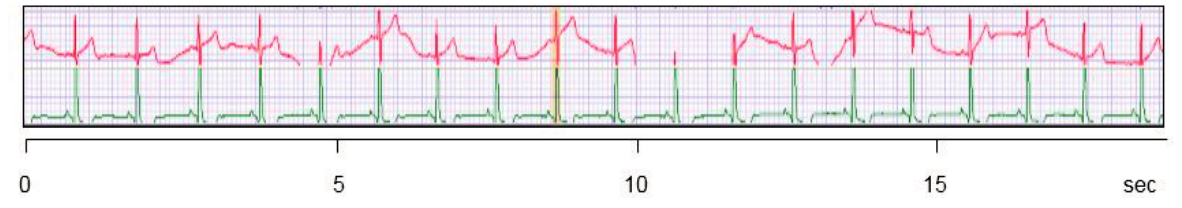
Figure 4. Electrode signals. Red : embroidered moist electrodes made from Ag-coated yarn worn with a chest belt; Green : classical Ag/AgCl gel electrodes. The test person wore the electrodes as shown in Figure 3a and was in light motion with a mean pulse of 60. For details see also the legend of Figure